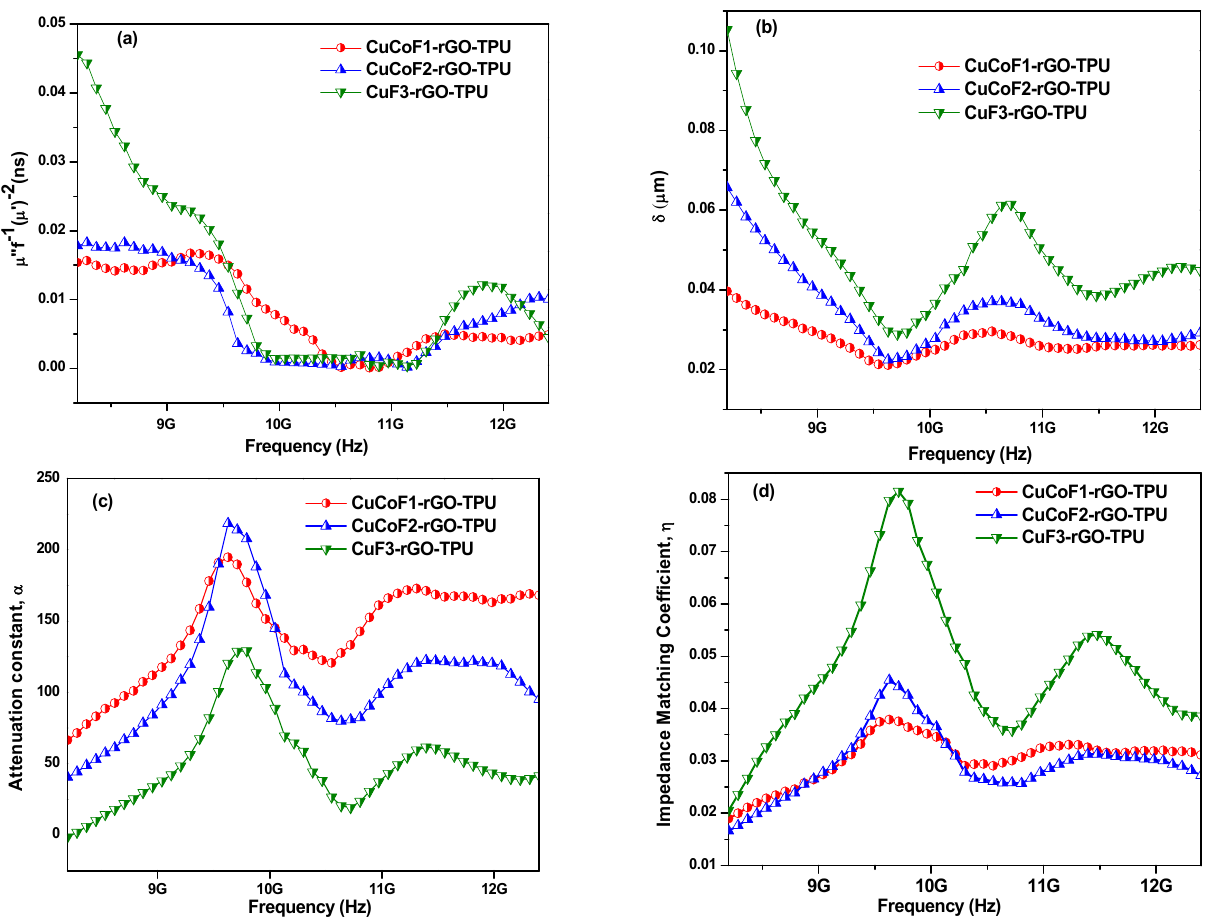
Figure 10. Variation of ( a ) eddy current loss, C o ( b ) skin depth, δ ( c ) attenuation constant, α and ( d ) impedance matching, Z with change in frequency for CuCoF1, CuCoF2, and CuF3 nanoparticles based nanocomposites along with rGO in TPU matrix.